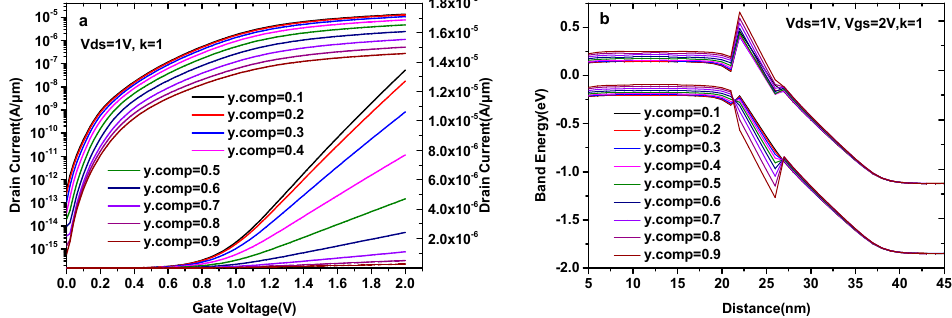
Figure 4. ( a ) Transfer characteristics of DMG-HJLTFET and ( b ) energy band diagram of DMG-HJLTFET with different y in GaAs y Sb 1 − y .